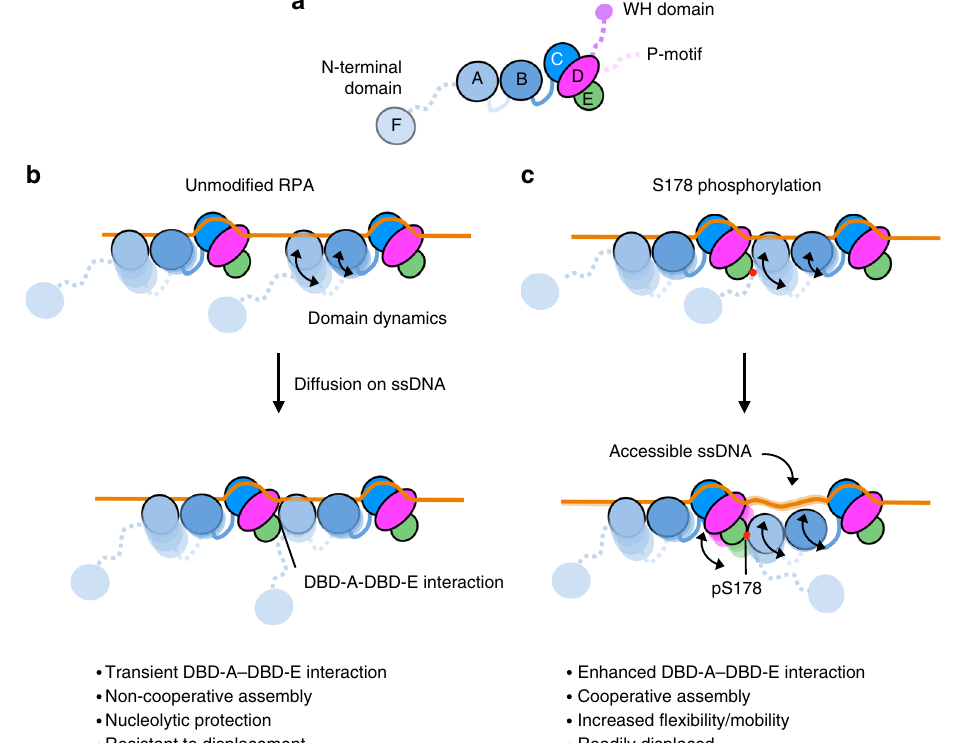
Fig. 7 Proposed model of DBD dynamics when multiple RPAs are associated with ssDNA. a Schematic of yeast RPA (ScRPA) illustrating the DNA-binding domains (DBDs) F, A, B, C, D. Subunits of the RPA heterotrimer (Rfa1, Rfa2, and Rfa3) are colored as in Fig. 2. The winged-helix domain (WH) and phosphorylation motif (P-motif) of Rfa2 are also shown for completeness. b Unmodi fi ed RPA binds to ssDNA tracts with varying conformational states. DBD-A and DBD-B are dynamic, whereas the Tri-C is more stable. Through diffusion on ssDNA RPAs can interact with each other via an interaction between DBD-A and DBD-E. This interaction allows RPA to pass ssDNA from one molecule to another. c An S178D phosphomimetic mutant RPA has an enhanced DBD-A – DBD-E interaction that results in cooperative assembly of RPA on ssDNA. The positioning of DBD-A may not be associated with ssDNA and this allows easier access of the nucleic acid to other processing factors such as